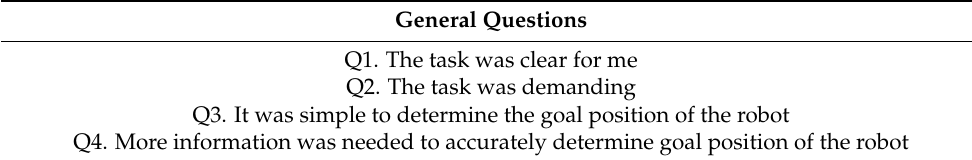
Table 2. General questions for all the tested interfaces.